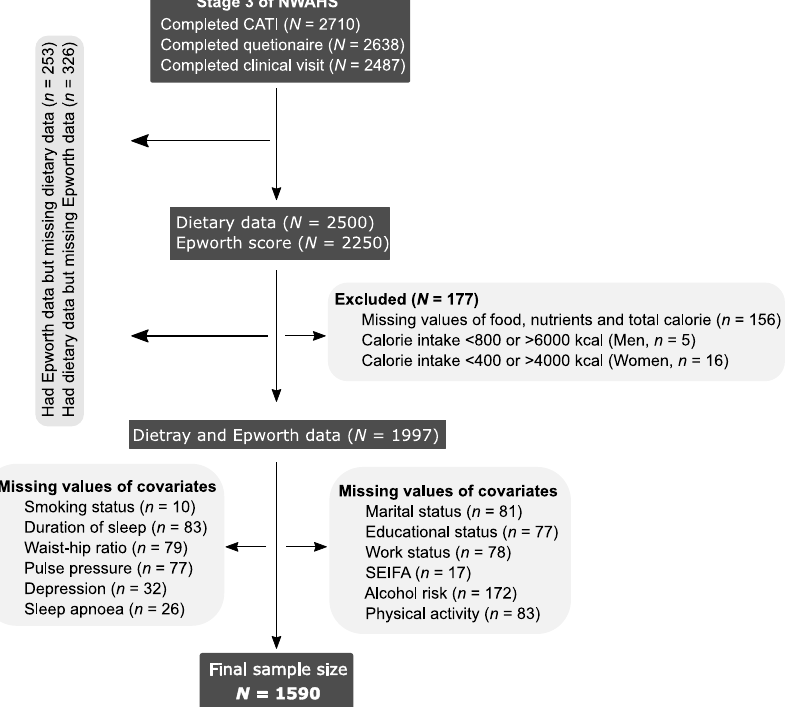
Figure 1. Sampling scheme. CATI—computer assisted telephone interview; NWAHS—North West Adelaide Health Study; SEIFA—socio-economic index for area.